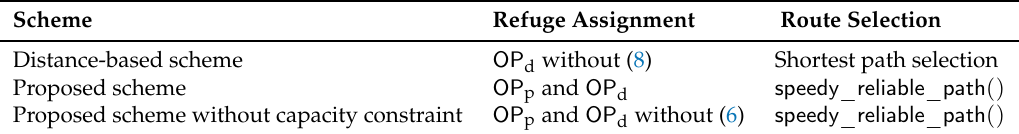
Table 2. Schemes for evaluation.